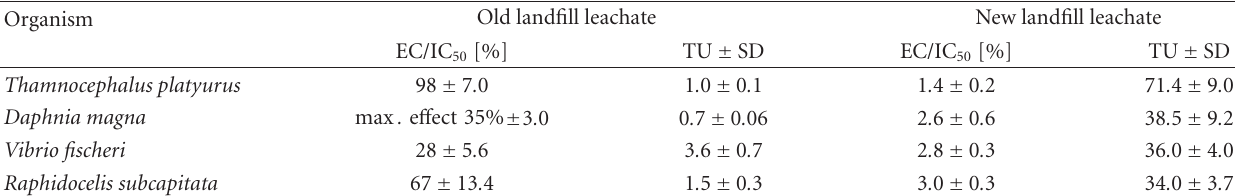
Table 7: Results of landfill leachate toxicity tests (average values from three experiments). Organism